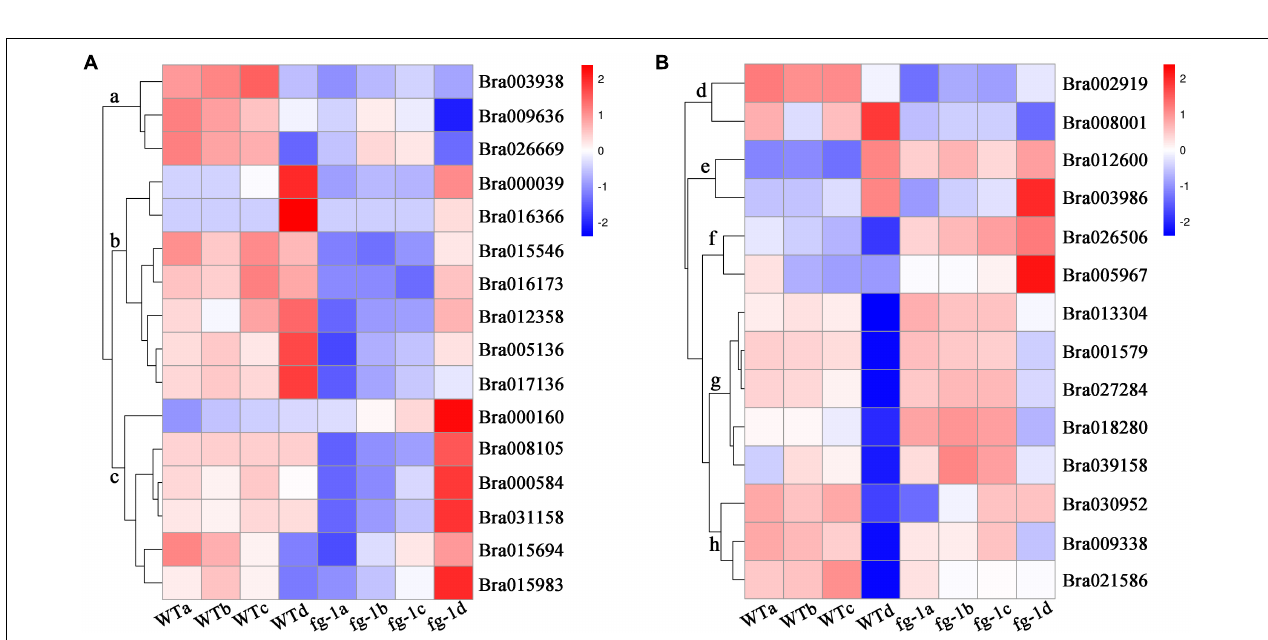
FIGURE 4 | Expression profile of the auxin influx and efflux carrier genes, IAMT1 and TCP s. The bar on the right side of the heat map represents relative expression values where 2, 0, and –2 represent high, intermediate and low expression, respectively. Red indicates relatively high gene expression levels and deep blue indicates relatively low gene expression levels. (A) The expression differences in auxin influx and efflux carrier genes in four leaf sections of the fg-1 mutant and wild type. (B) The expression differences in BrIAMT1 and BrTCP genes in four leaf sections of the fg-1 mutant and wild type.